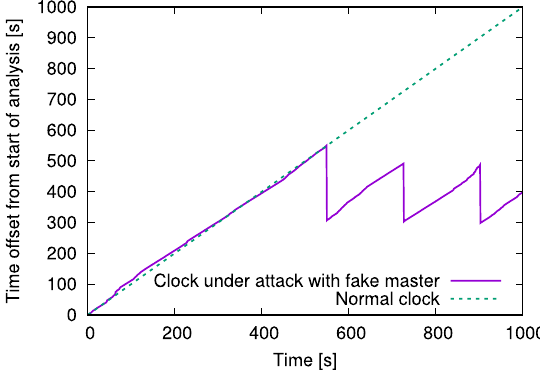
Fig. 8 When the attacker is elected as the master, the other clocks in the system are completely controllable. This graph shows a running query of the internal clock of a victim, compared with the internal clock value of a previously synchronized external